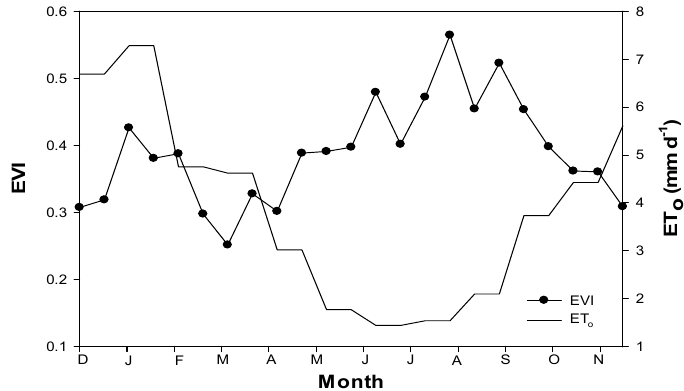
Figure 3. MODIS Enhanced Vegetation Index and potential evapotranspiration (ET) for Veale Gardens, December 2011 to November 2012.